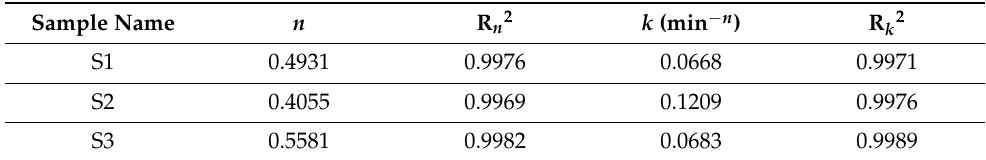
Table 2. Carvacrol release kinetic parameters.